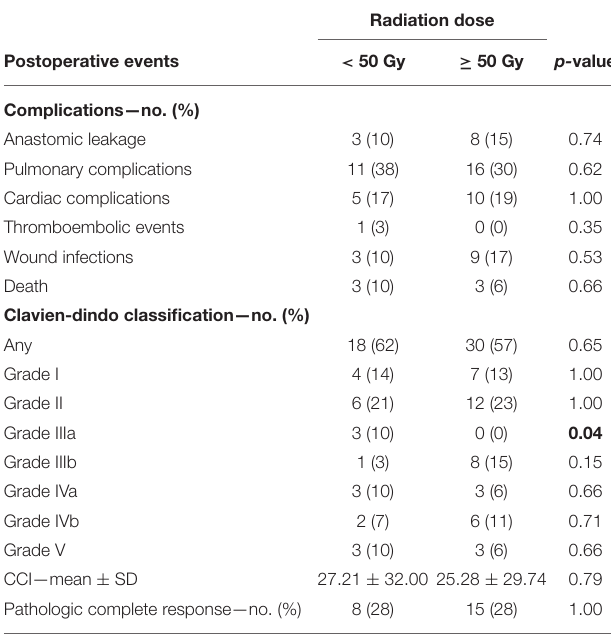
TABLE 1 | Patient and treatment characteristics.